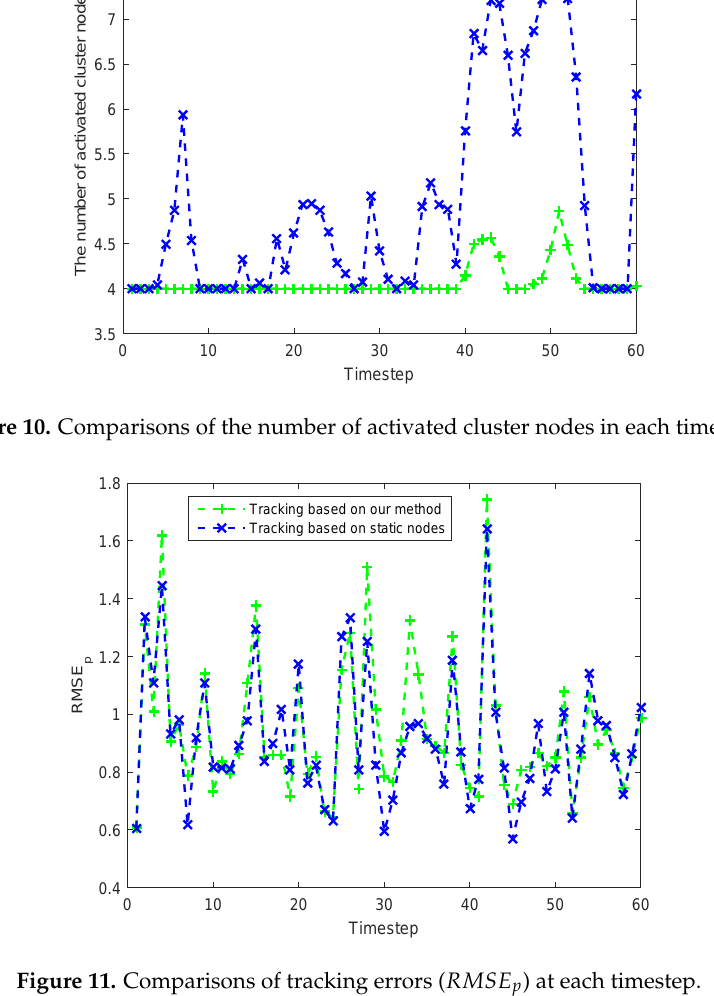
Figure 11. Comparisons of tracking errors ( RMSE p ) at each